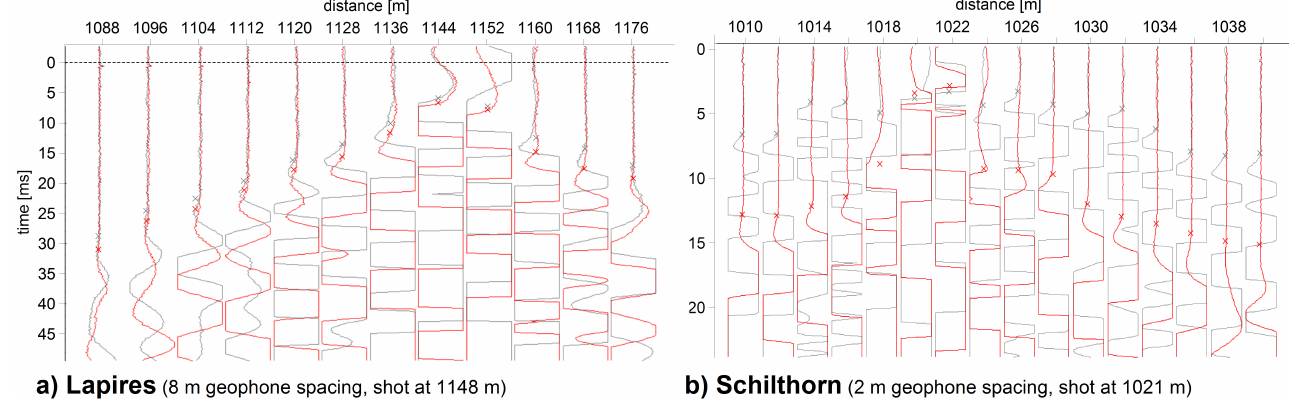
Fig. 3. Detailed view of a time-lapse seismogram from (a) Lapires with traces and picked first arrivals from 10 July (grey) and 18 August 2008 (red), and from (b) Schilthorn with traces and picked first arrivals from 11 July (grey) and 26 August 2008 (red). Note the time shifts of the first arrivals for the later date.